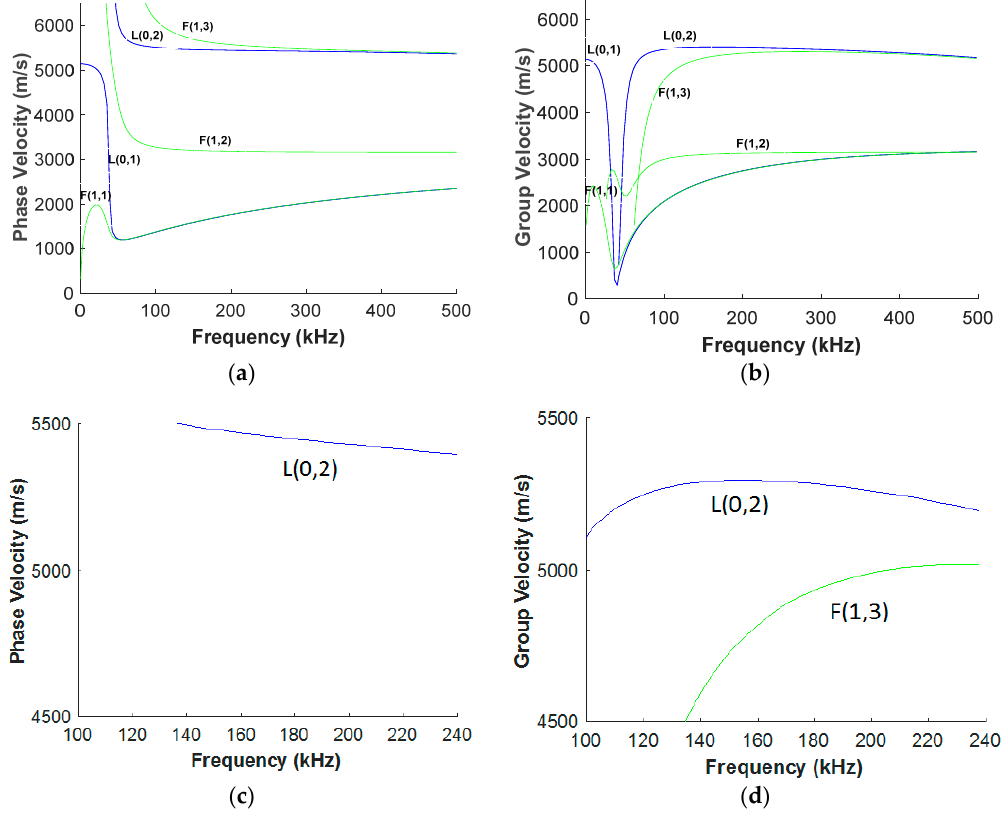
Figure 1. ( a ) Phase; and ( b ) group velocity dispersion curves for a steel pipe with a diameter of 33 mm and 4 mm in wall thickness. ( c ) Phase; and ( d ) group velocity dispersion curves for the same pipe within the least dispersive frequency region.